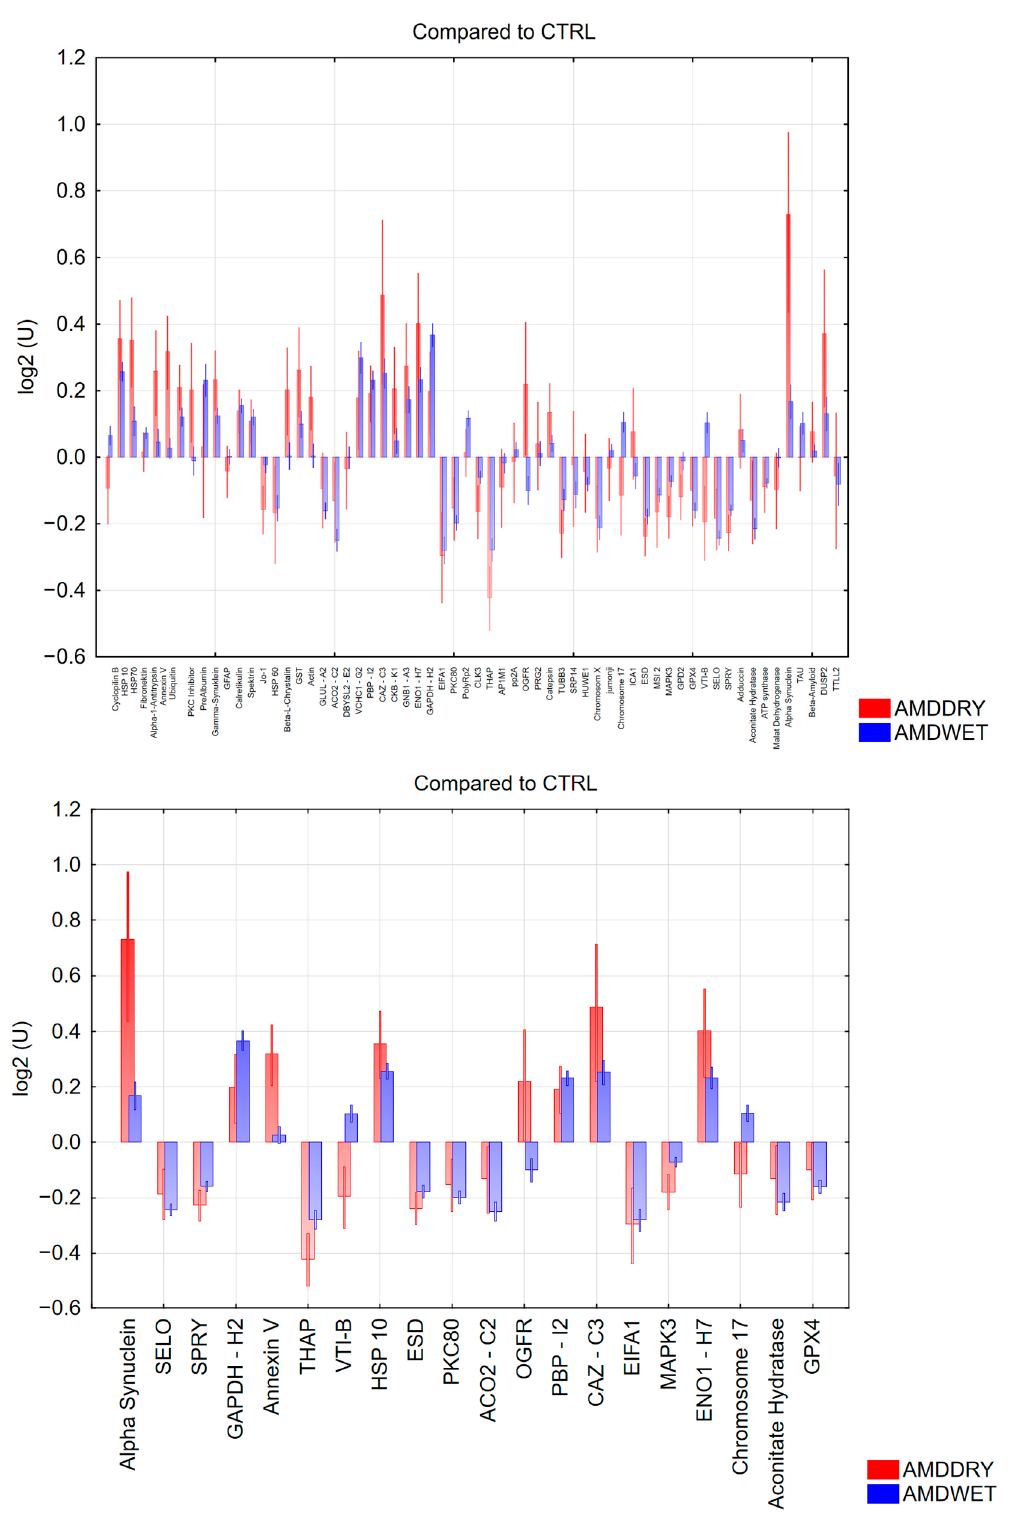
Figure 1. Comparison of immunoreactivities from dry AMD and wet AMD samples compared to CTRL. Top : all immunoreactivities; bottom : 20 most significant